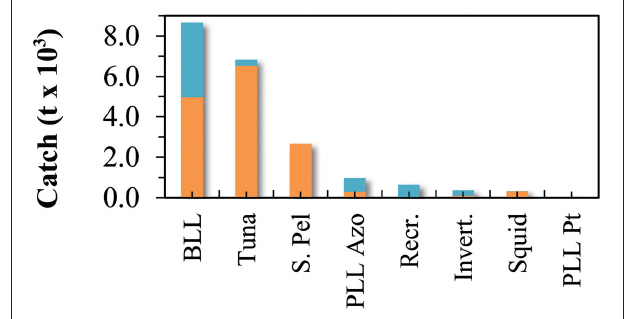
FIGURE 3 | Marine fisheries catch for the different fleets included in the Azores ecosystem model, for the reference year 1997 (adapted from Pham et al., 2013). BLL is deep-water bottom longline and handline fisheries, Tuna refers to the pole and line tuna fishery (including the live-bait catch), S. Pel refers to the small-size pelagic fisheries, PLL Azo is the Azores pelagic longline fisheries, Recr. is the recreational fishing, Invert. is the commercial coastal invertebrates fisheries, Squid is the squid ( L. forbesii ) fisheries, and PLL Pt refers to the Portuguese mainland pelagic longline fisheries.